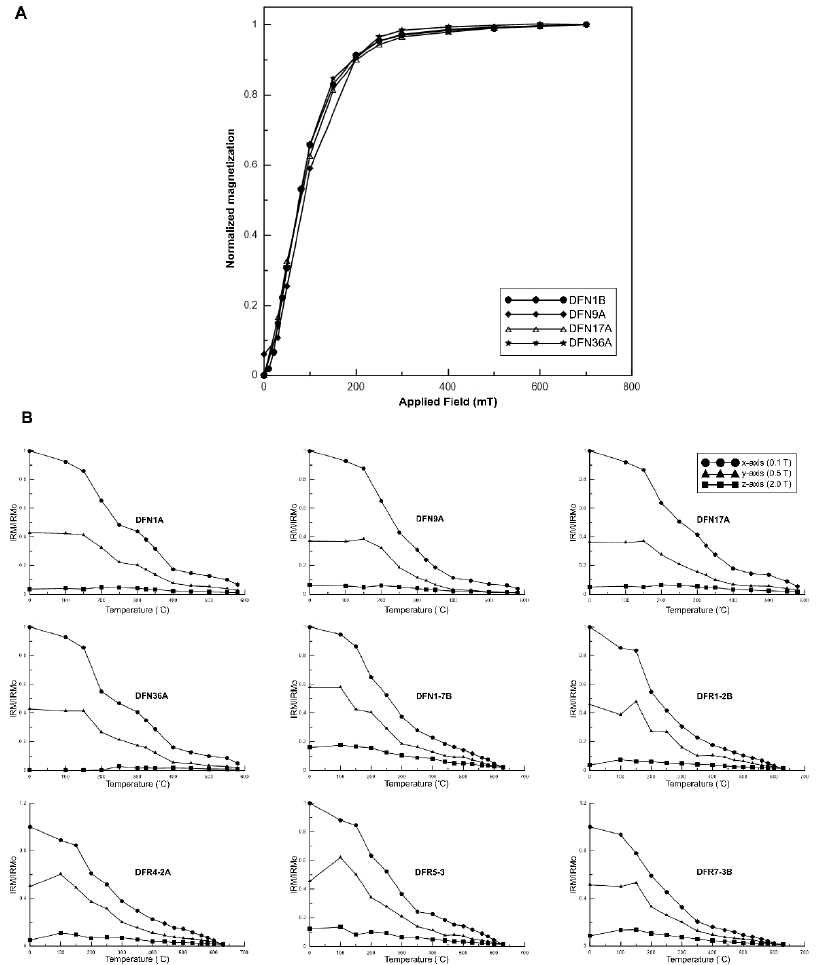
Figure 2. ( A ) Stepwise acquisition of an isothermal remanent magnetization (IRM) up to fields of 700 mT. ( B ) Examples of thermal demagnetization of a composite IRM acquired on three orthogonal axes.